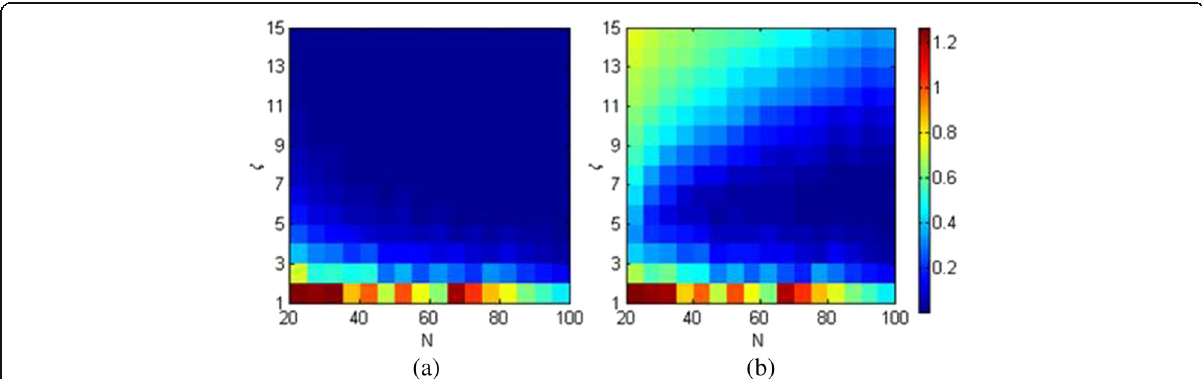
Fig. 4 Relative reconstruction error variation with increased E-spline smoothness order N under different stretching factors ζ . a is in the case that b = ζ /W when b is in the case that b = 1 /W